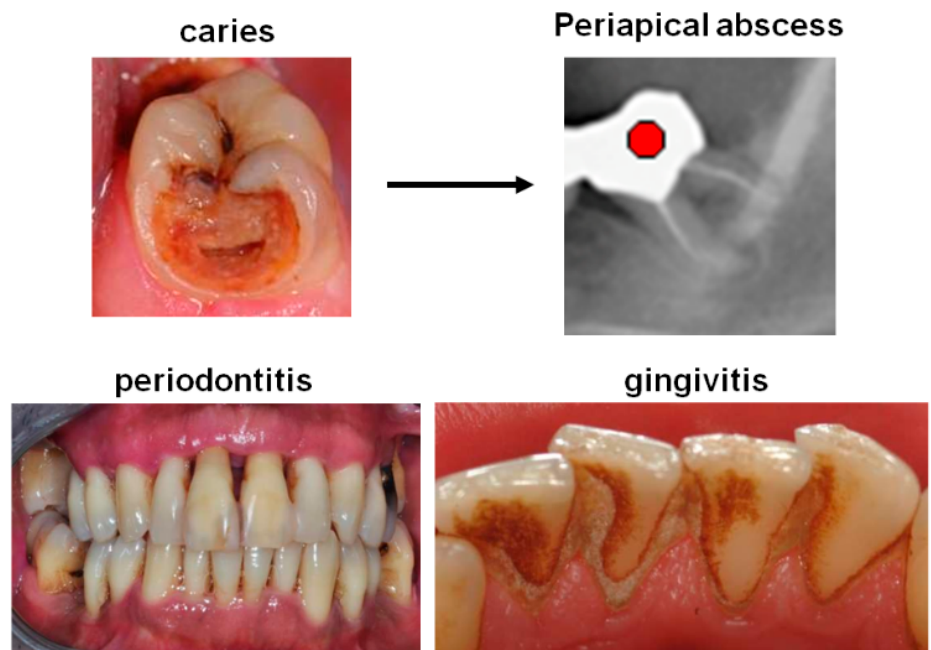
Figure 1. Oral inflammation affecting the teeth, gingiva, and the periodontium. Shown are examples of a tooth affected by severe caries, a tooth with abscess formation revealed by orthopantomography, a denture with severe periodontitis with evidence of extensive loss of attachment and gingival recession at most teeth, and an example of gingivitis with extensive calculus formation and a swollen and reddened inflamed gingiva.